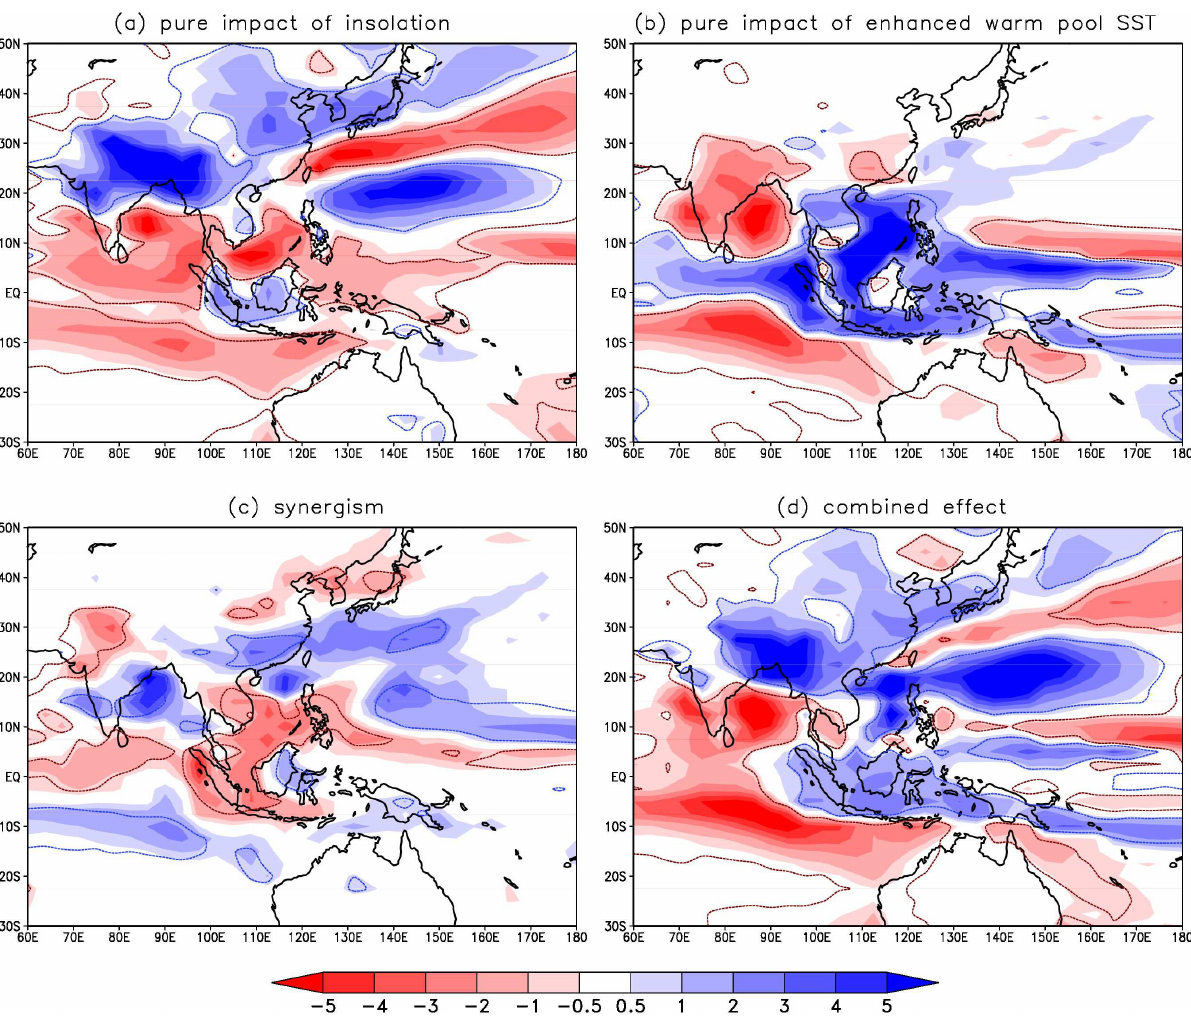
Figure 4. Same as Fig. 2 except for summer precipitation anomaly (mmday − 1 ). Areas with significance level greater than 99% are sur- rounded by contour